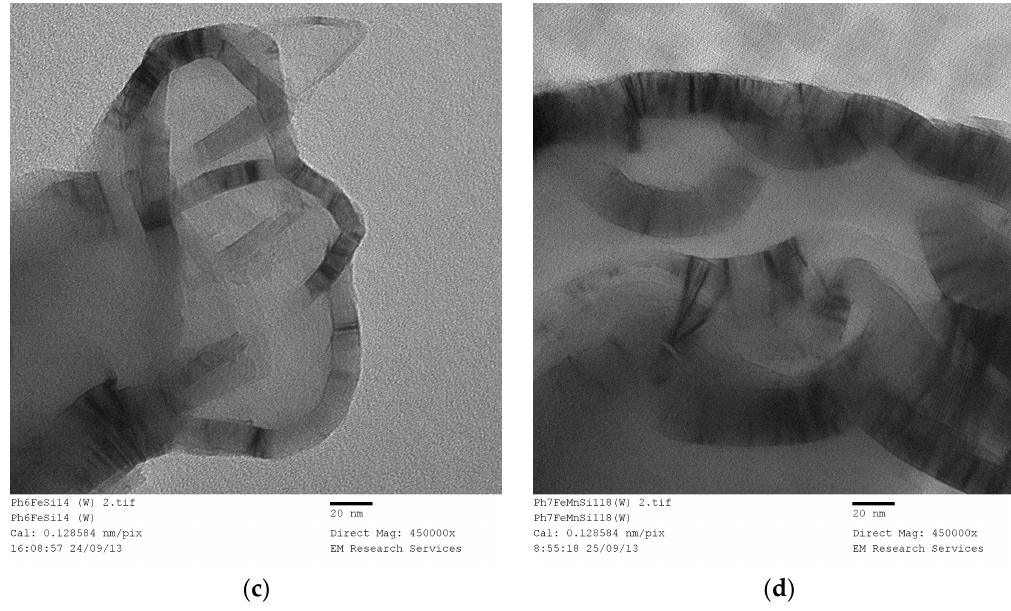
Figure 23. TEM images of several Fe/Si and Fe/Mn/Si catalysts with varying compositions and processing history. ( a ) Fe/Si = 1/4 Mw ‐ AB (Bar = 20 nm); ( b ) Fe/Si = 1/4 Mw ‐ ABCD (Bar = 20 nm); ( c ) Fe/Si = 1/4 Ph ‐ washed (Bar = 20 nm); ( d ) Fe/Mn/Si = 1/1/8 Ph ‐ washed (Bar = 20 nm).